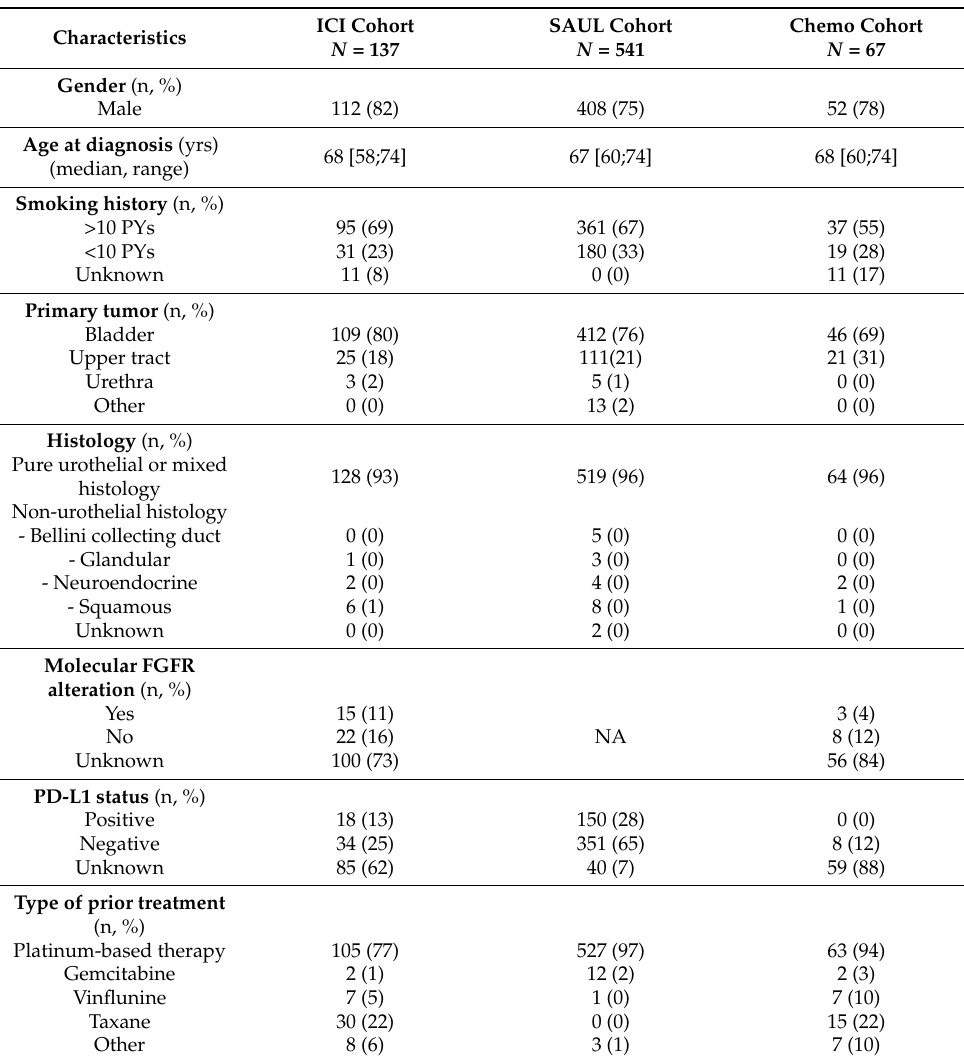
Table 1. Baseline patient and disease characteristics for the ICI, SAUL and Chemo cohorts. ANC: ab- solute neutrophil count; Chemo: chemotherapy; dl: deciliter; dNLR: derived neutrophils/(leukocytes minus neutrophils) ratio; ECOG: Eastern Cooperative Oncology Group; g: grams; ICI: immune checkpoint inhibitor; LDH: lactate dehydrogenase; LIPI: lung immune prognostic index; mo: